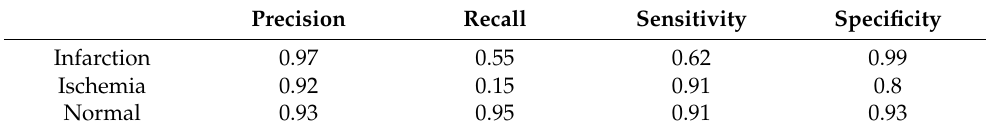
Table 4. Presentation of values of efficient metrics of DenseNet-121 model for each class. Precision Recall Sensitivity Specificity Infarction 0.97 0.55 Normal 0.93